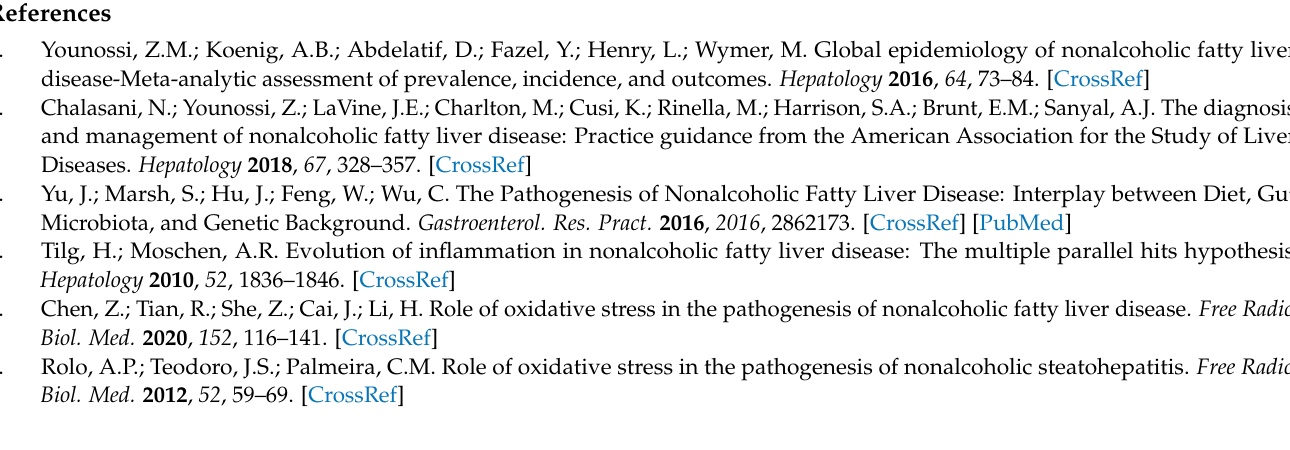
table for comparisons of HIS and CAU with NASH vs. 0-NASH, Table S4: Targeted quantification data table for comparisons of HIS and CAU with NASH in the secondary analysis, Table S5: Pearson’s correlation analysis between LOX metabolites and markers of oxidative stress, Table S6: Details on detected lipid class and identifiers, Figure S1: Venn-Diagram illustrating overlapping and unshared differences in polyunsaturated fatty acids (PUFAs) and lipid mediators between non-alcoholic fatty liver (NAFL) compared to healthy control (HC) in both ethnicities, Figure S2: Differences in plasma PUFA and lipid mediators between Hispanic (HIS) and Caucasian (CAU) in lean healthy subjects, Figure S3: Supervised multivariate clustering model demonstrating ethnicity specific oxylipins profile discriminates Hispanic (HIS) and Caucasian (CAU) with non-alcoholic steatohepatitis (NASH) with advanced fibrosis, Figure S4: Flow chart illustrating subject recruitment details for primary and secondary analysis, Figure S5: Principal component analysis (PCA) illustrating outliers before (left) and after (right) data normalization, Figure S6: Principal component analysis (PCA) illustrating the unsupervised clustering of samples from primary (red) and secondary cohort (green) shown before (left) and after (right) batch